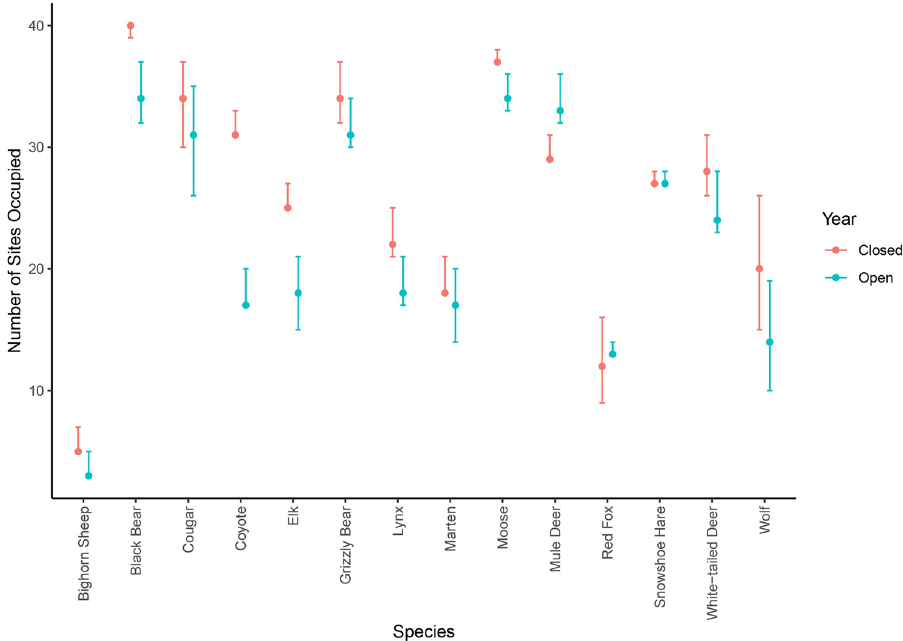
Figure 2. Estimated number of camera sites used (+ −95% CIs) by 14 mid- to large-sized mammals in a year closed to recreation and a year open to recreation based on dynamic occupancy models. Estimates from 10,000 bootstrapped simulations of presence/absence at sites based on conditional (latent) occupancy estimates of the best-fitting dynamic occupancy model for each